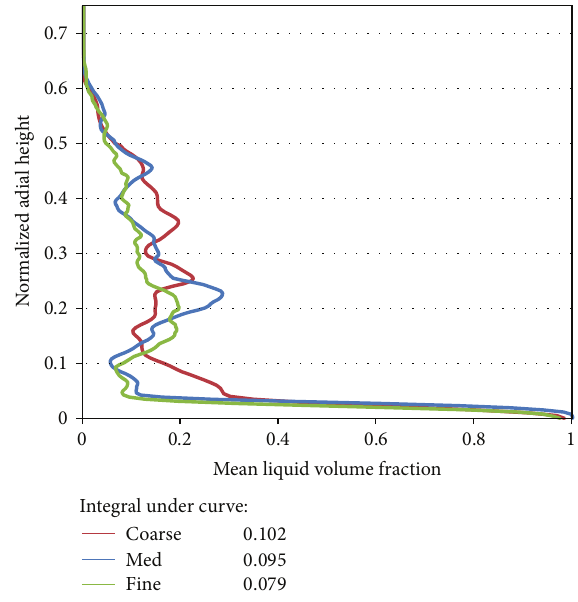
Figure 10: Plot of time-averaged liquid fraction on the rotor side (as a function of normalized height). Integrated values for the total liquid “coverage” are shown in the